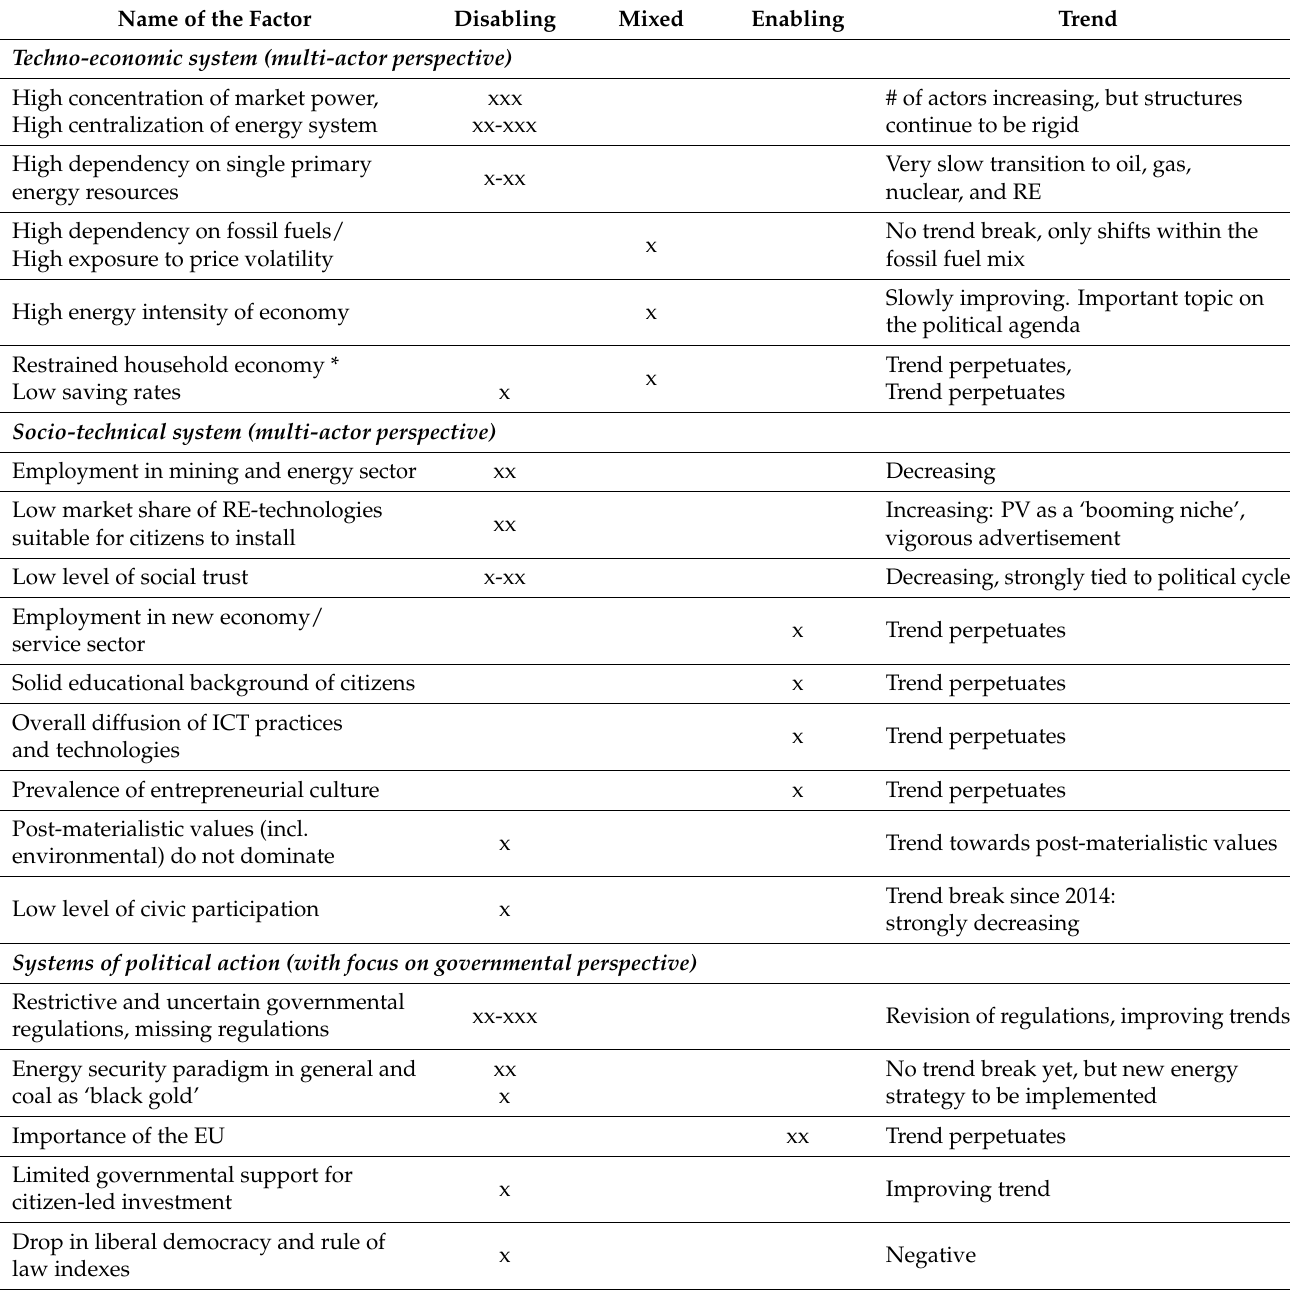
Table 5. Ranking of enabling and disabling factors. * including electricity